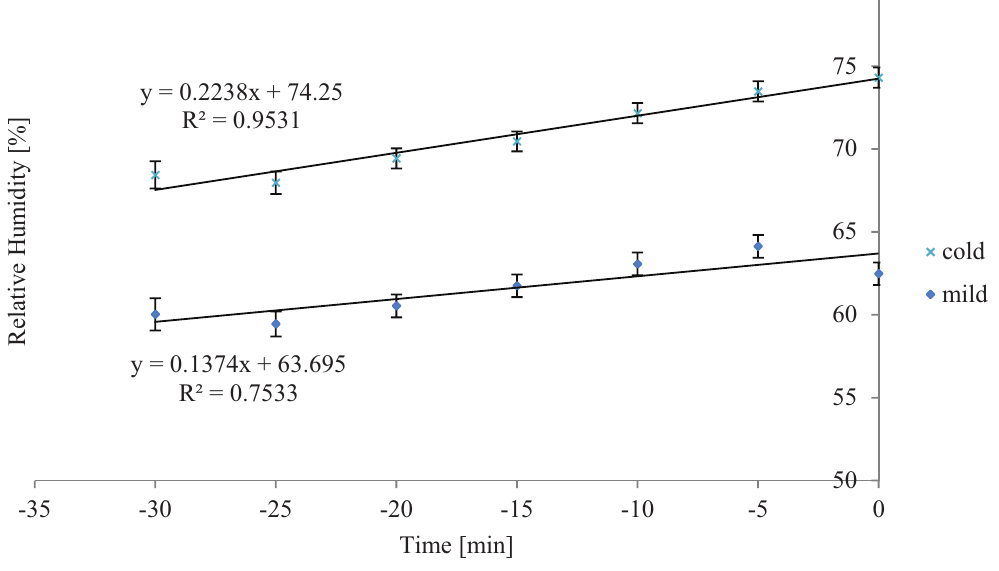
Figure 2. Overall time effect on average internal trailer relative humidity inside while loading during winter and mild weather ( P < 0.01 and P < 0.01, respectively). Cold SEb = 0.02, n = 33 trailers; Mild SEb = 0.02, n = 21 trailers. While slopes differed from zero, they did not differ between cold and mild seasons/temperatures ( P = 0.50). Time zero represents when the trailer departed and (cid:2)30 minutes is the time loading began.